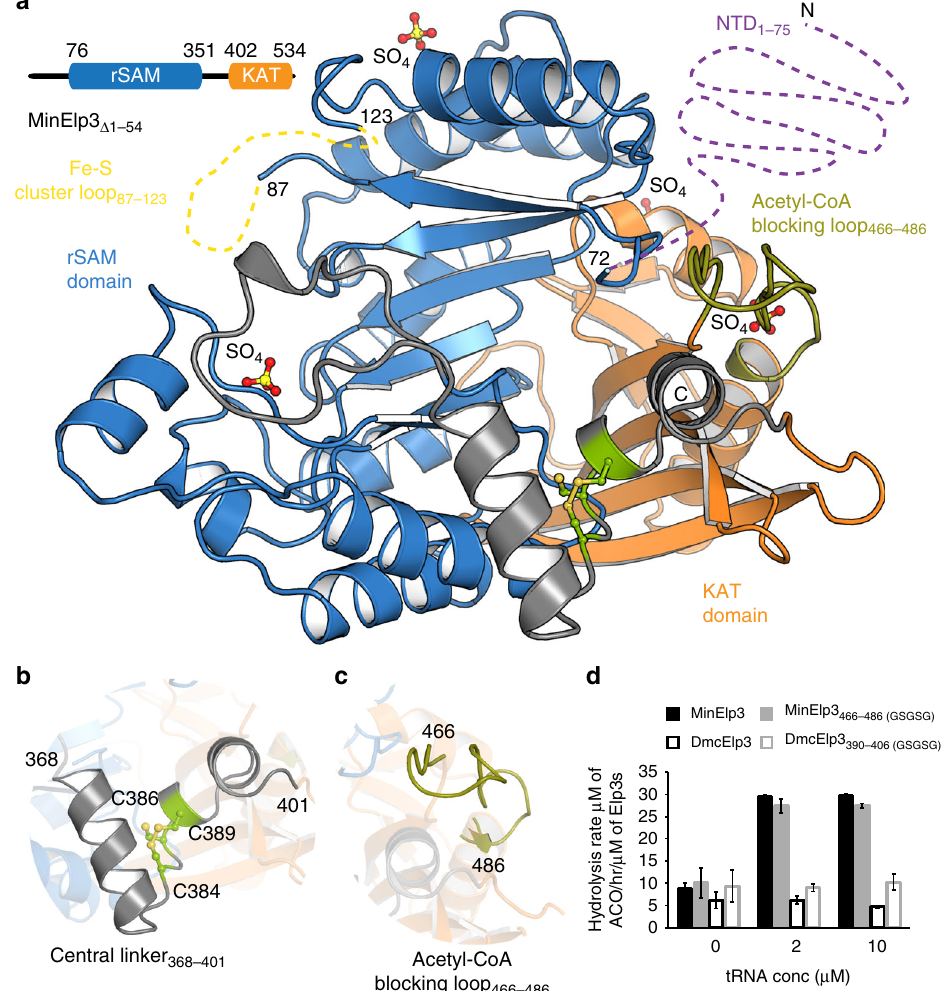
Fig. 2 The crystal structure of MinElp3 Δ 1 – 54 . a Overall structure of MinElp3 Δ 1 – 54 in cartoon representation. The rSAM domain (blue), KAT domain (orange), acetyl-CoA blocking loop (olive), and central linker region (gray) are highlighted. Disordered loops are shown using dotted lines. Cysteines in the central linker region are highlighted in green and SO 4 is shown as orange and red spheres. The respective amino acid numbers are indicated. b Close-up view of the central linker region that connects rSAM and KAT domains. The three cysteine residues involved in disul fi de bond formation are indicated (yellow). c Close-up view of the acetyl-CoA blocking loop (olive). d The acetyl-CoA hydrolysis rates of MinElp3, MinElp3 466 – 486(GSGSG) , DmcElp3 and DmcElp3 390 – 406 Δ elp3; UMY2916). Data represent mean ± standard error of the mean (SEM). Source (GSGSG) in the absence and presence of endogenous yeast bulk tRNA ( data are provided as a Source Data